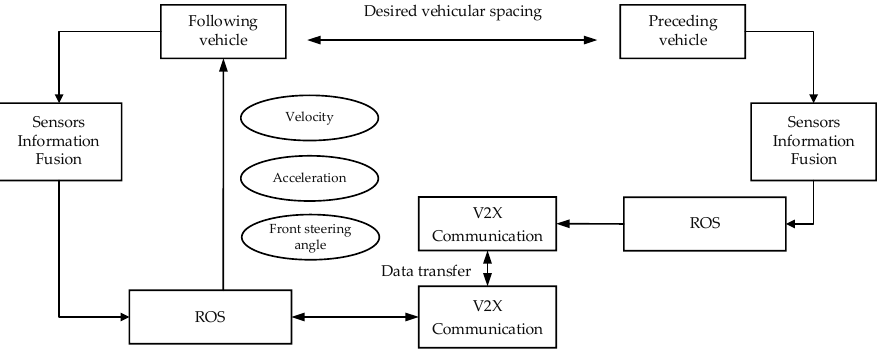
Figure 3. The communication network of the cooperative car-following system.